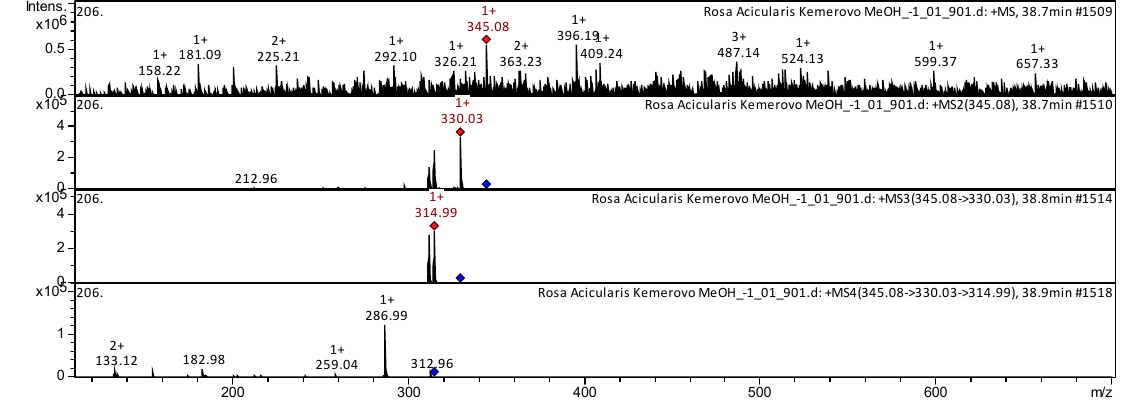
Figure 5. CID-spectrum of Nevadensin from extracts of R. acicularis , m / z 346.86. The [M + H] + ion produced two fragment ions at m / z 330 and m / z 212 (Figure 5). The fragment ion with m / z 330 yielded one daughter ion at m / z 314. The fragment ion with m / z 314 yielded five daughter ions at m / z 312, m / z 286, m / z 259, m / z 182, and m / z 133. It was identified in the bibliography in extracts of Ocimum [19] and Mentha [26].